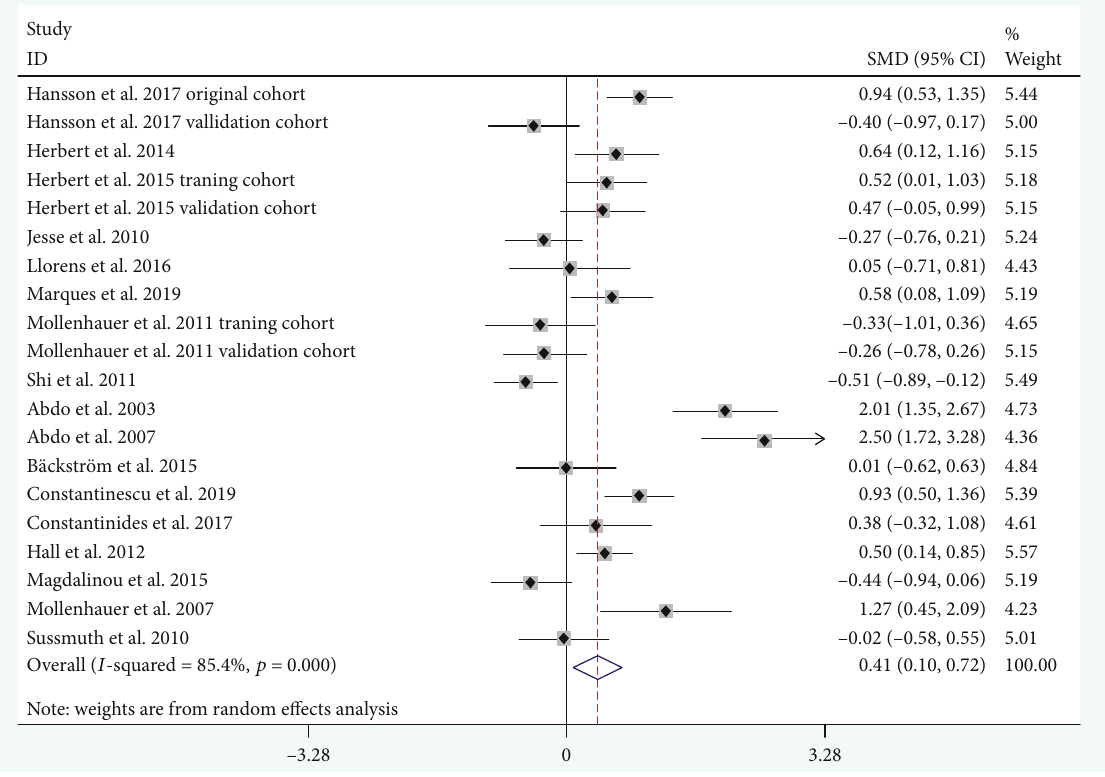
Figure 3: Cerebrospinal fl uid (CSF) levels of total microtubule-associated protein (t-tau) in multiple system atrophy (MSA) cohorts were higher than those in Parkinson ’ s disease (PD)